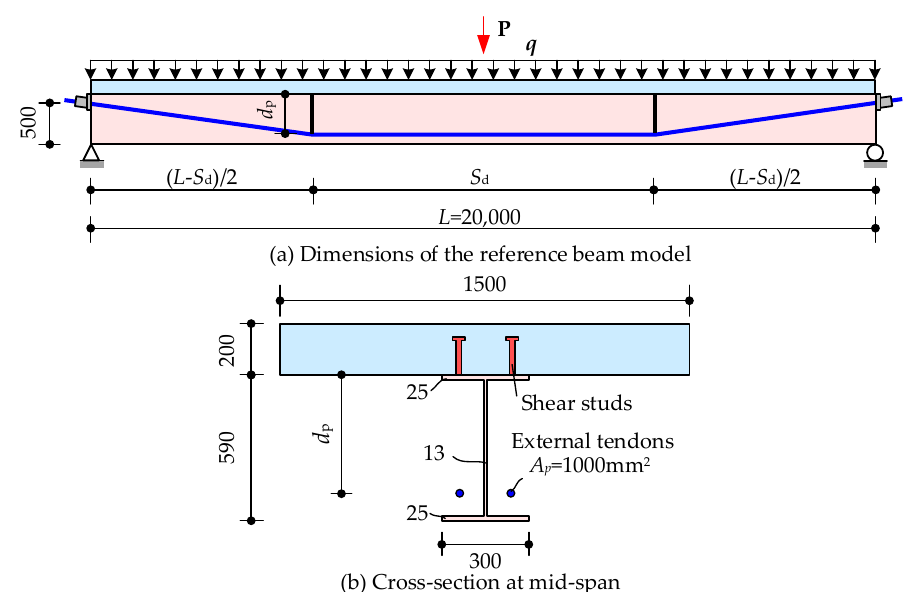
Figure 17. Structural details of the reference model.